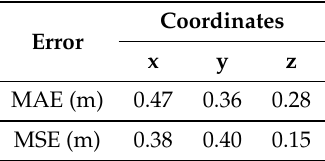
Table 7. Overall errors of the coordinates estimation module on the dataset.